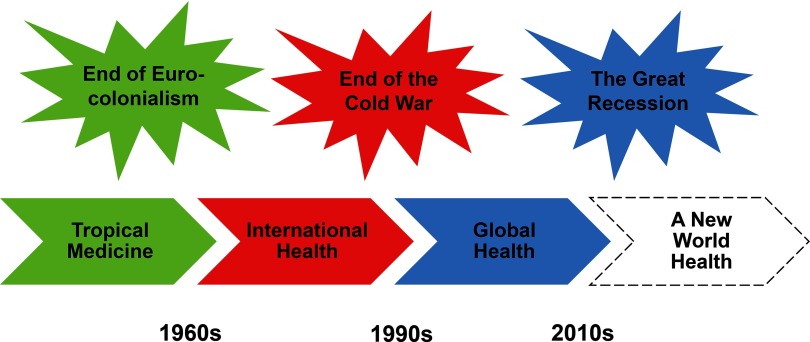
A New Chapter in International Health HistoryNote: This graph is only a didactic tool; historical periods often overlap and vary from one country or region to another, and many components of one period carry over to future ones.